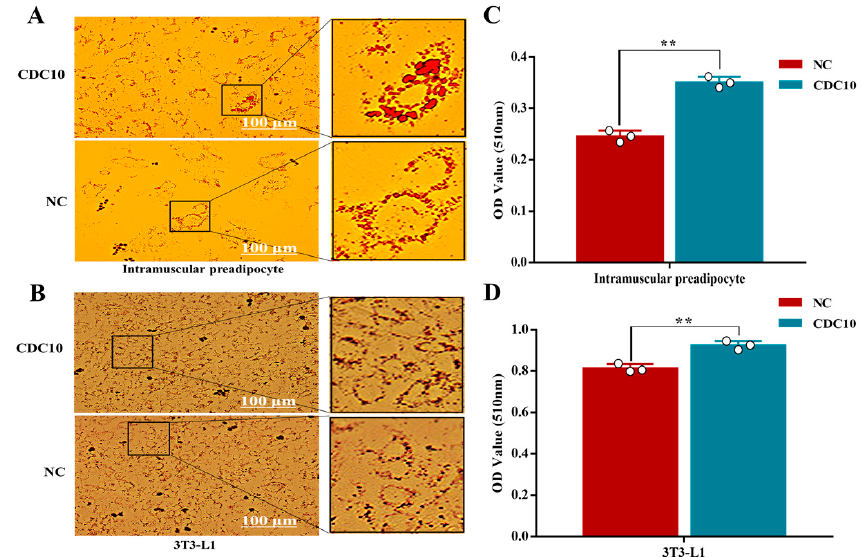
Figure 9. The effect of CDC10 overexpression on the differentiation of bovine intramuscular preadipocyte (BIMP) and 3T3-L1 cells was detected by Oil Red O staining. BIMP and 3T3-L1 cells were transfected with lentivirus for 9 d during differentiation. ( A , B ) Oil Red O staining. ( C , D ) Oil Red O relative absorbance. Values are expressed as mean ± SEM ( n = 3). ** p < 0.01.